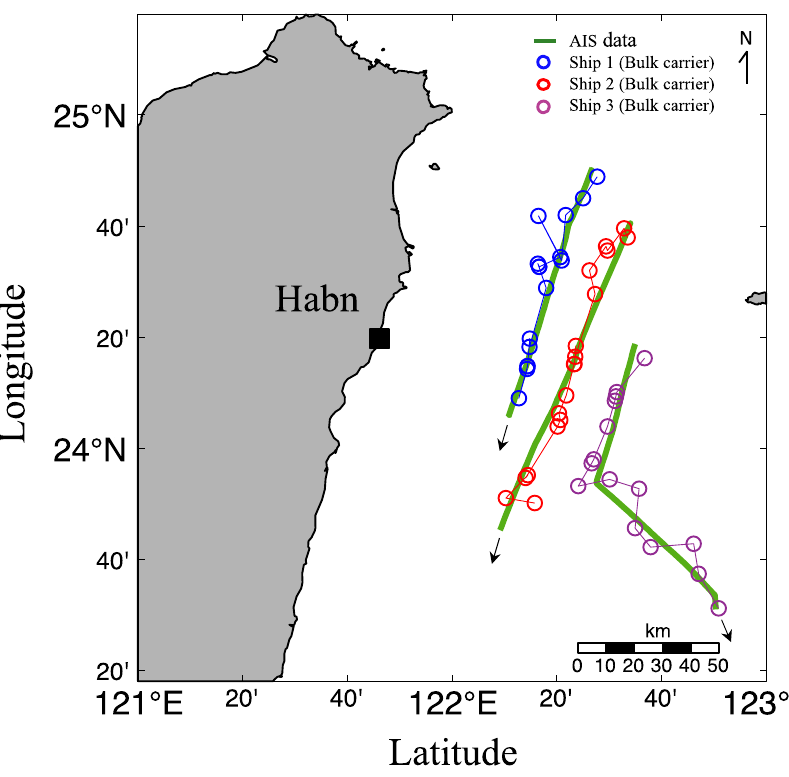
Figure 11. Trajectories of vessels from 29 October 2013 to 31 October 2013; the blue dots are the trajectory predictions of ship 1 at 04:34–09:08 on 29 October 2013; the red dots are those of ship 2 at 00:53–05:43 on 29 October 2013; the purple dots are those of ship 3 at 20:30 on 30 October 2013 to 02:52 on 31 October 2013. The three green lines are the actual tracks from the AIS database. Therefore, this article analyzes the SNR value of each detection point and its angular error (Figure 12). The horizontal axis is the SNR value, and the vertical axis is the angular error. The average SNR value and the angular error value are 13.4 dB and 6.3 degrees, respectively (the green dashed lines on the vertical and horizontal axes in the figure). The r-square statistical value obtained from linear regression of this dataset is 0.52779; typically, a value greater than 0.5 is considered acceptable [37,38].